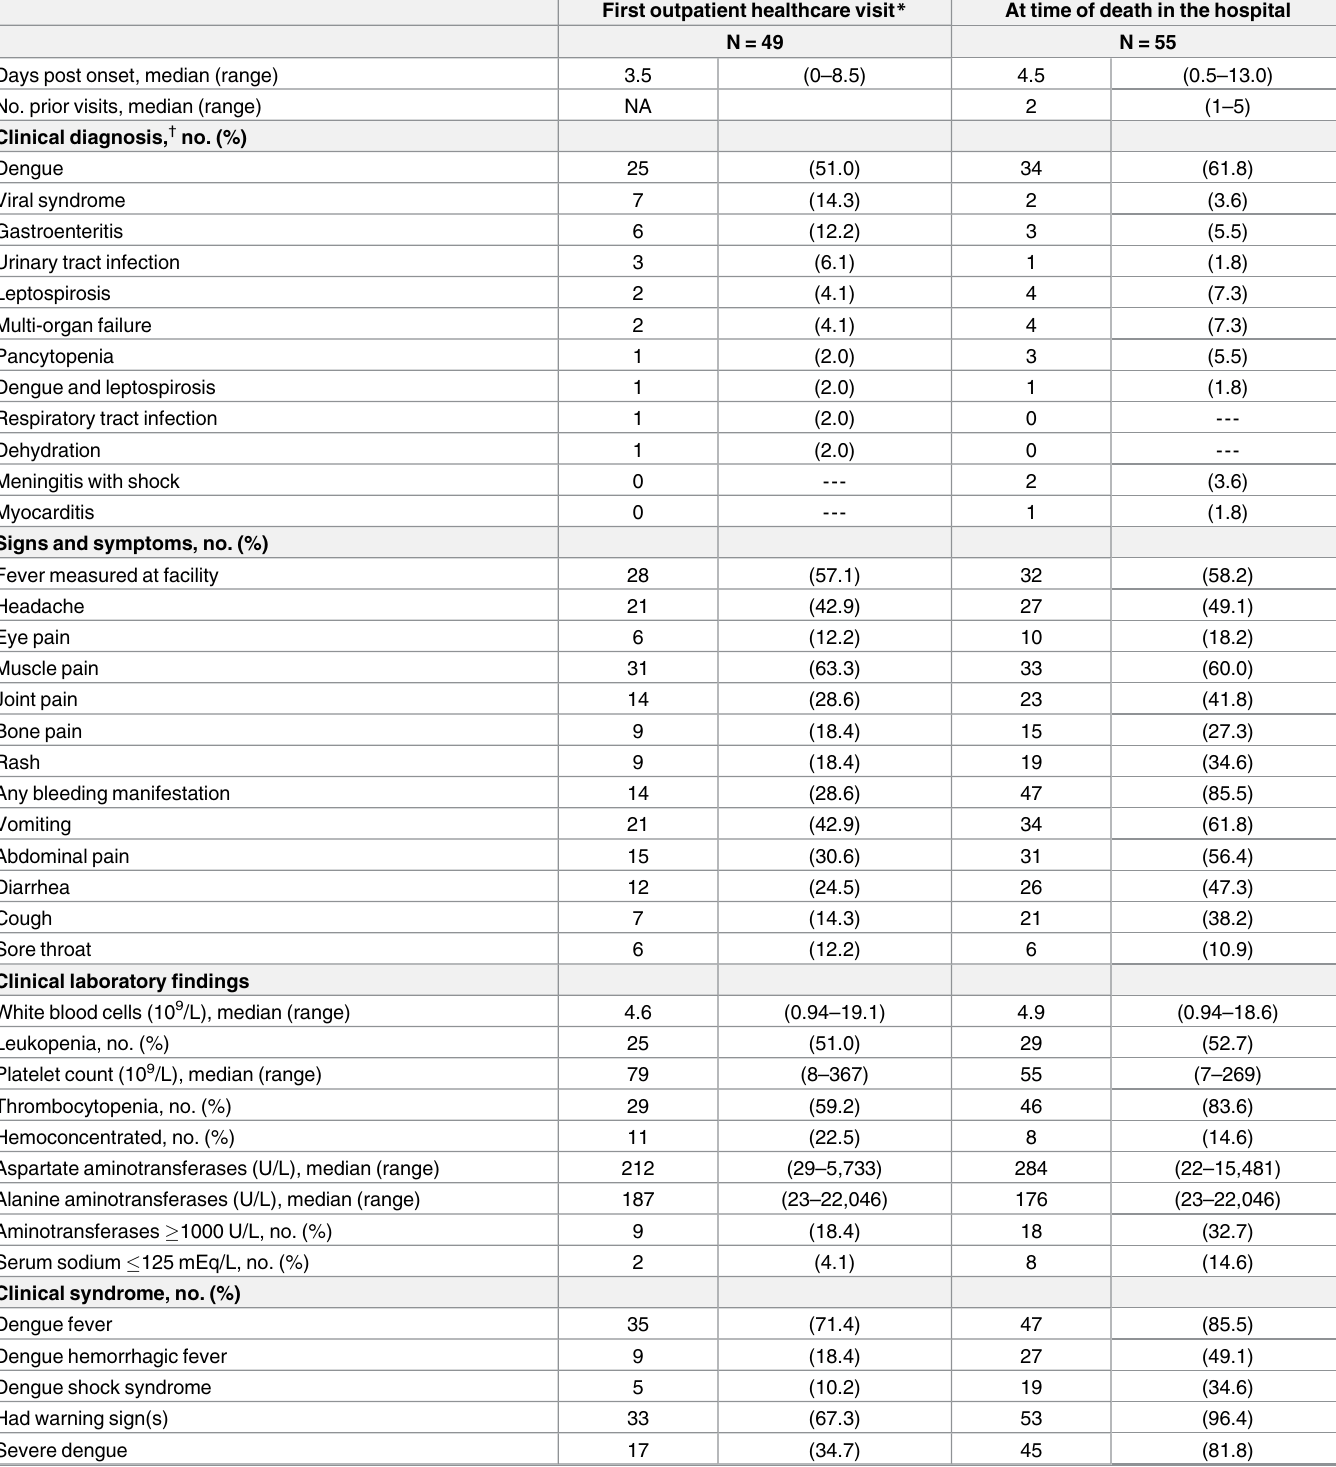
Table 4. Clinical features and outcomes for fatal laboratory-positive dengue case-patients detected by the Enhanced Fatal AFI Surveillance Sys- tem, Puerto Rico, 2010–2012. First outpatient healthcare visit